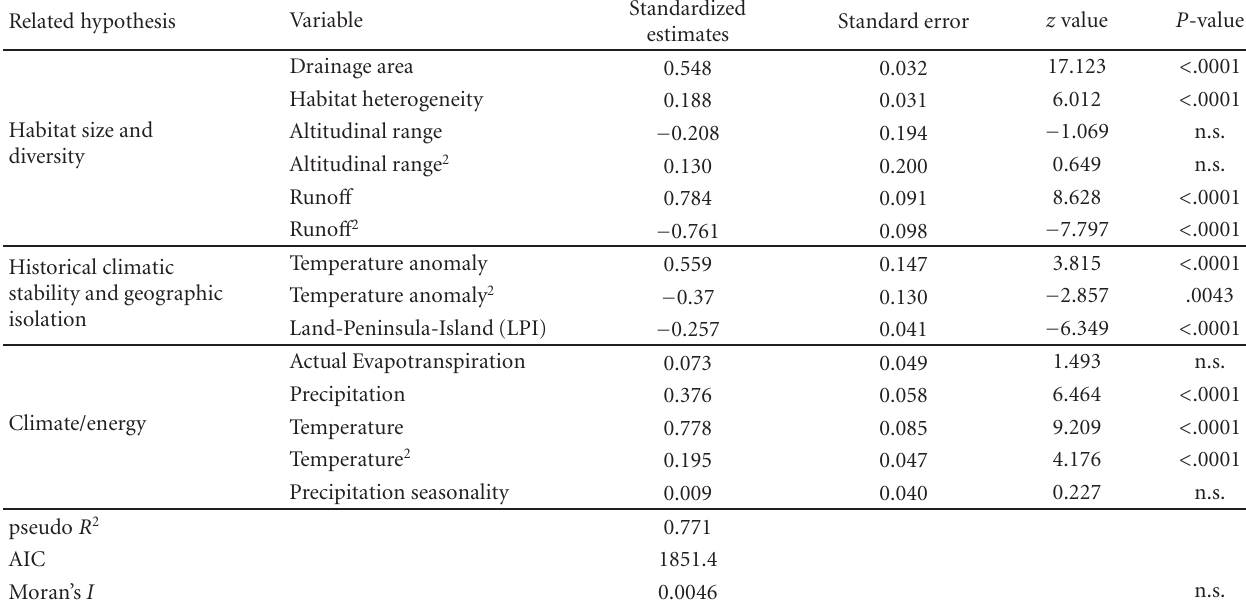
Table 1: Results from a spatial autoregressive model (SAR) relating species richness to environmental, climatic, and historical variables. Spatial analysis was performed with R statistical package [49] and spdep library [50] (see the Supplementary Appendix for further explanations). The spatial structure was implemented by a neighbourhood matrix of the drainage basins (see [46] and the Supplementary Appendix for further explanations) and assuming that the autoregressive process occurs in the error term (i.e., the “spatial error model” described by Dormann et al. [44]). Further methodological details on species richness, environmental variables computing, and modelling procedure are available in the Supplementary Appendix. Habitat heterogeneity was estimated by applying Shannon’s diversity index to proportions of biomes (i.e., vegetation types associated with regional variations in climate) within drainage basins. Temperature anomaly represents the Quaternary climate variability measured as the change in mean annual temperature between the present and the Last Glacial Maximum (LGM, circa 21 thousand years ago). Following Oberdor ff et al. [51] we also considered whether or not a drainage basin was on a land mass, a peninsula, or an island (LPI; continental mass = 0; peninsula = 1; island = 2). All other variables are fully explained in the Supplementary Appendix. The Moran’s I value represents the remaining autocorrelation on the residuals of the model for the first distance class, that is, neighbour drainages (the values for the remaining distance classes are also